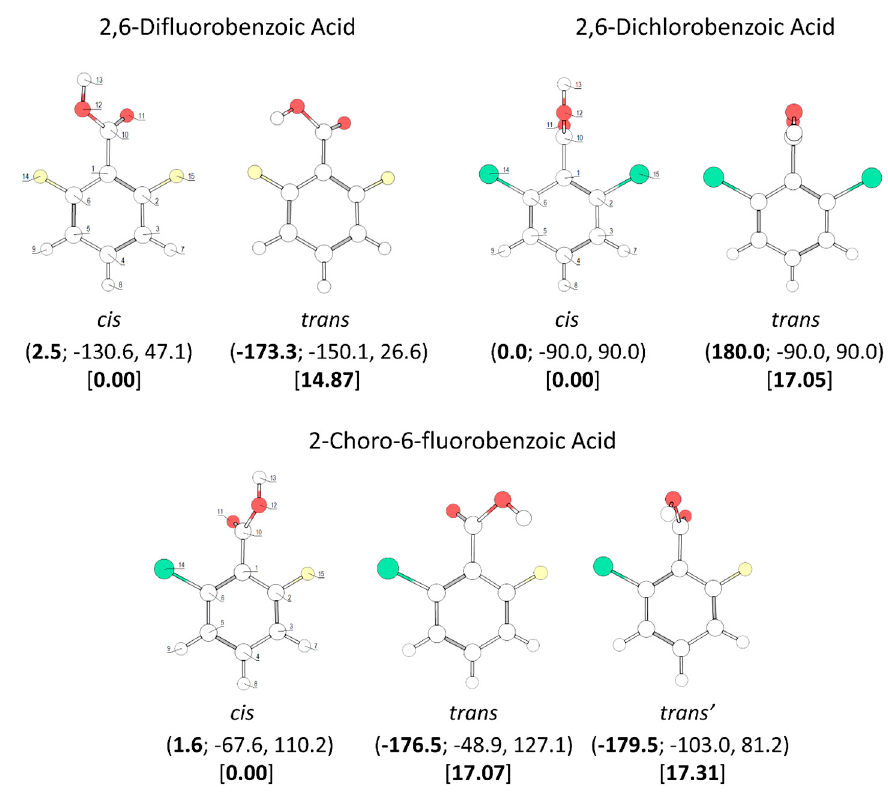
Figure 2. B3LYP / 6-311 ++ G(d,p) calculated minimum energy structures of 2,6-difluorobenzoic acid, 2,6-dichlorobenzoic acid and 2-chloro-6-fluorobenzoic acid, with adopted atom numbering. The values of the O = C-O-H, C6-C-C = O and C2-C-C = O dihedral angles (in o ) are given in parentheses by this order (the first in bold style). Relative energies are given in square parentheses (in bold), in kJ · mol − 1 . Each conformer of 2,6-dichlorobenzoic acid and 2-chloro-6-fluorobenzoic acid has a symmetry-related identical form; the conformers of 2,6-difluorobenzoic acid have 4 symmetry-equivalent structures.